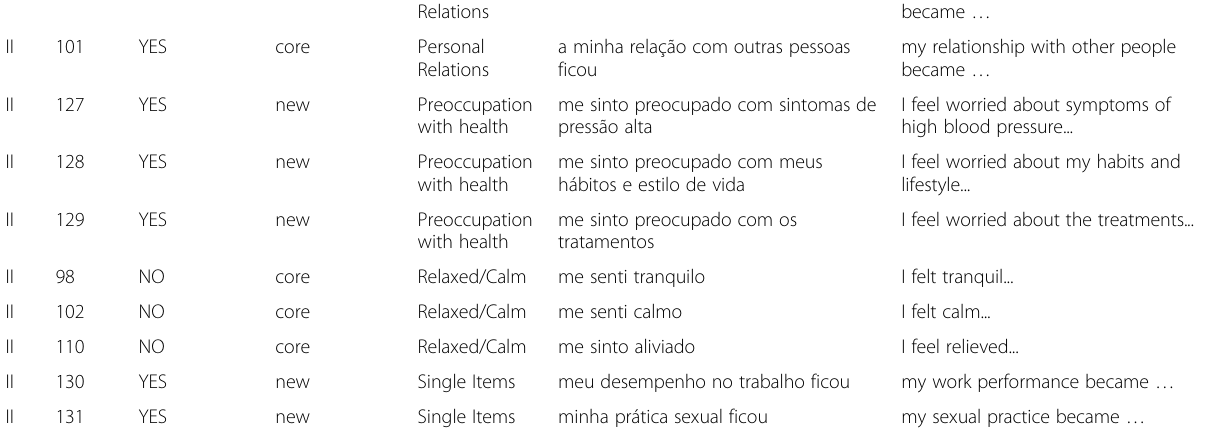
together with a shaded area that indicates the 95% confidence region of the model expectations. Thus, when curves are contained in the shaded area, the observed data match the model expectations and thus indicate item